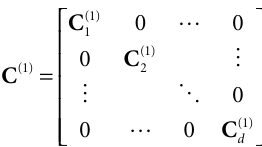
and Y ). This model 1 2